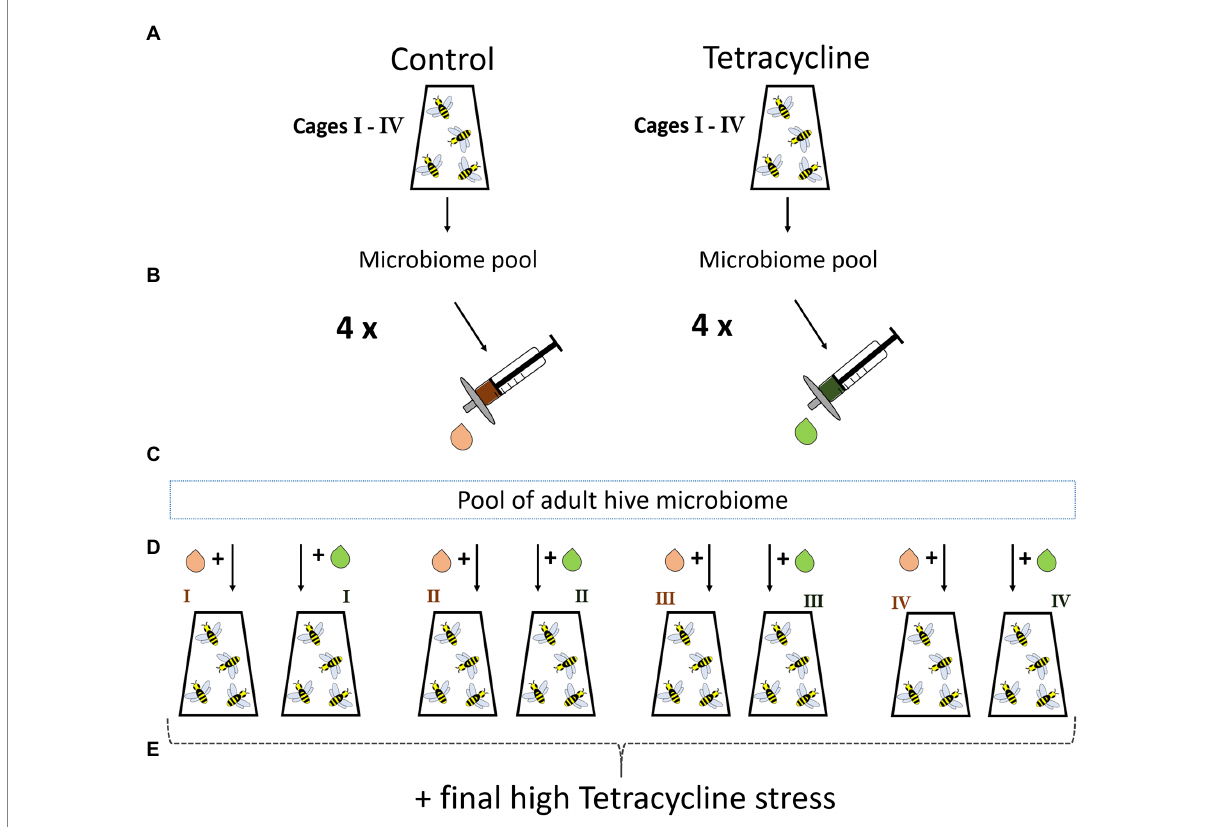
FIGURE 2 Control experiment with filtered gut solution. Emerged bees with transferred natural nurse microbiome are raised in four cages with control or tetracycline diet for 6 days (A) . On day six a bee gut pool for each cage is prepared as done in the first experiment and filtered to exclude microbes but to keep all potential tetracycline and derivates potentially present in the guts (B) . A microbiome pool of hive sibling guts is generated to allow a healthy background microbiome for newly emerged bees for the next cycle (C) . This microbiome pool is equally split and each part gets mixed with the filtrate of one control or tetracycline cage (D) . The bees receive sterile food for 6 days and are exposed to high tetracycline stress in the end and mortality is recorded (E)